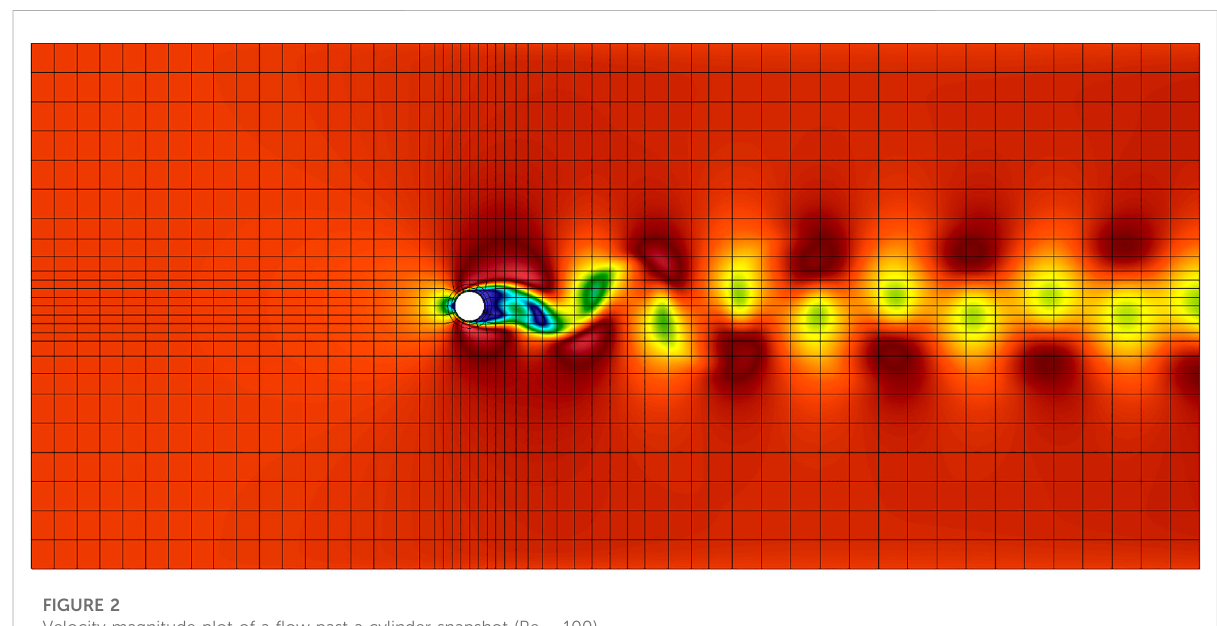
FIGURE 2 Velocity magnitude plot of a fl ow past a cylinder snapshot (Re =